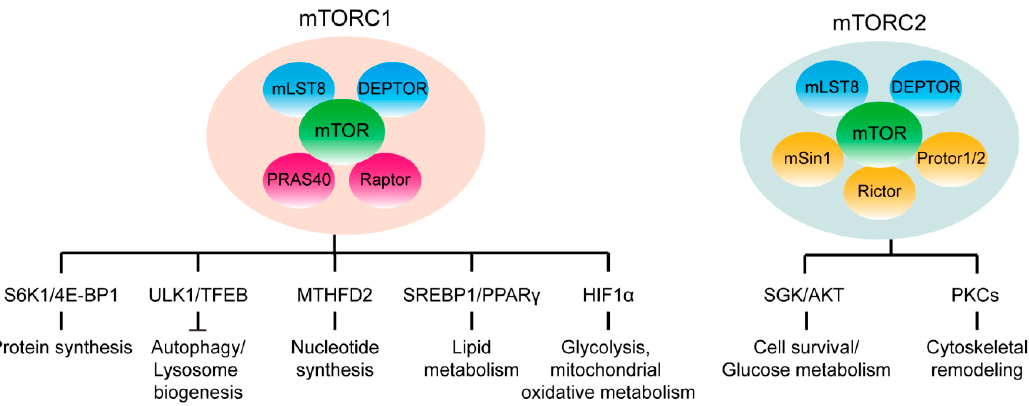
Figure 1. The protein components and the major downstream signaling pathway of mTORC1 and mTORC2. Simplified illustration of the protein components of mTORC1 and mTORC2 complex. Activation of mTORC1 promotes protein synthesis, nucleotide synthesis, lipogenesis, glycolysis, and inhibits autophagy and lysosome biogenesis. Alternatively, mTORC2 regulates cell survival/glucose metabolism and cytoskeletal